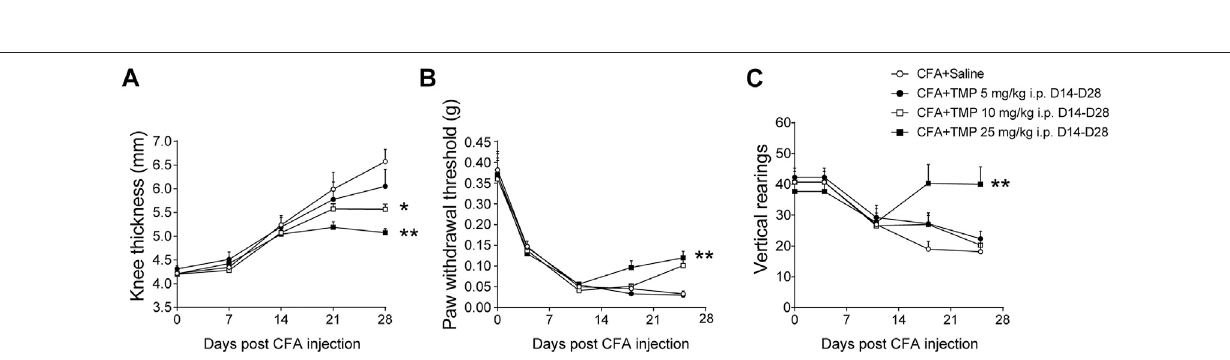
FIGURE5| Dosedependent effects ofTMP onmaintenance ofCFAinducedin fl ammatorypain. (A) The effect ofTMP onknee thickness. (B) The mechanical pain threshold between groups. (C) The vertical rearings with TMP administration between groups. Statistical comparison was performed with repeated measures two-way ANOVA with post Dunnett ’ s multiple comparisons. (* p < 0.05, ** p < 0.01, vs. CFA+Saline).